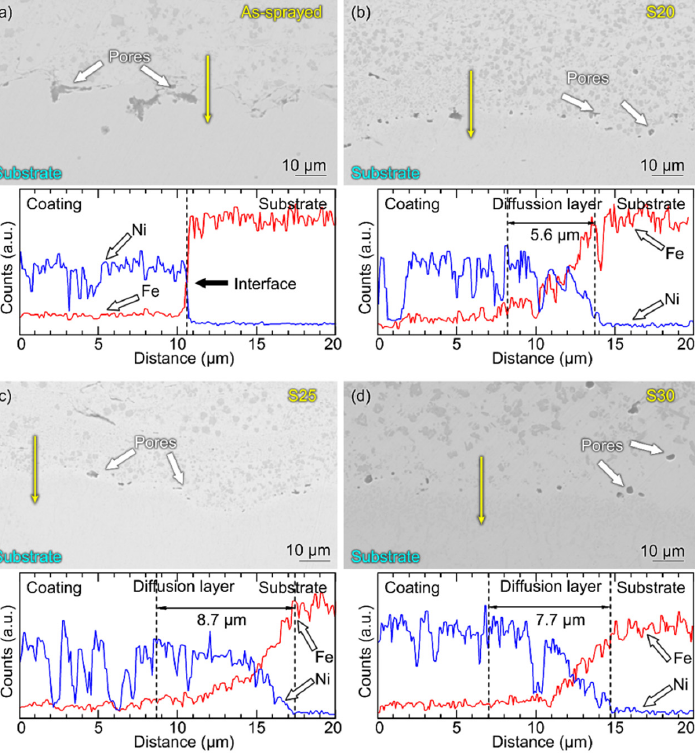
Figure 5. SEM observations for the interface morphologies of ( a ) the as-sprayed, ( b ) S20, ( c ) S25, and ( d ) S30 coating samples and their corresponding line scanning profiles of Ni and Fe elements at the interfaces. S20, S25, and S30 indicate the as-sprayed NiCrBSi coatings remelted at 20 kW, 25 kW, and 30 kW. The yellow arrows indicate the routes of EDS line scan.